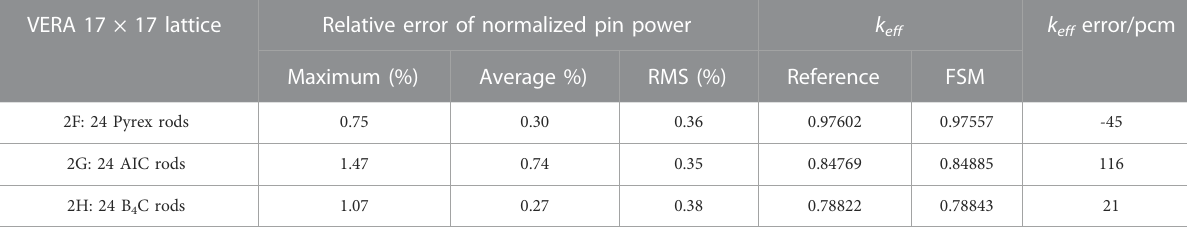
TABLE 11 Calculation results for VERA 2F, 2G, and 2H lattice problems. VERA 17 × 17 lattice